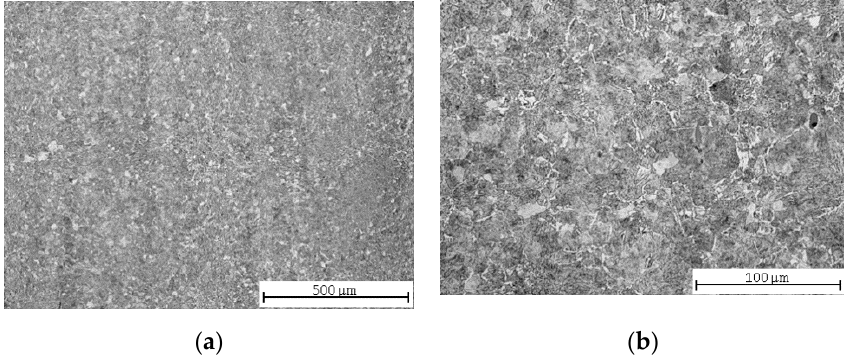
Figure 4. Quenched and tempered C45 steel microstructures: ( a ) central part; ( b ) detail.